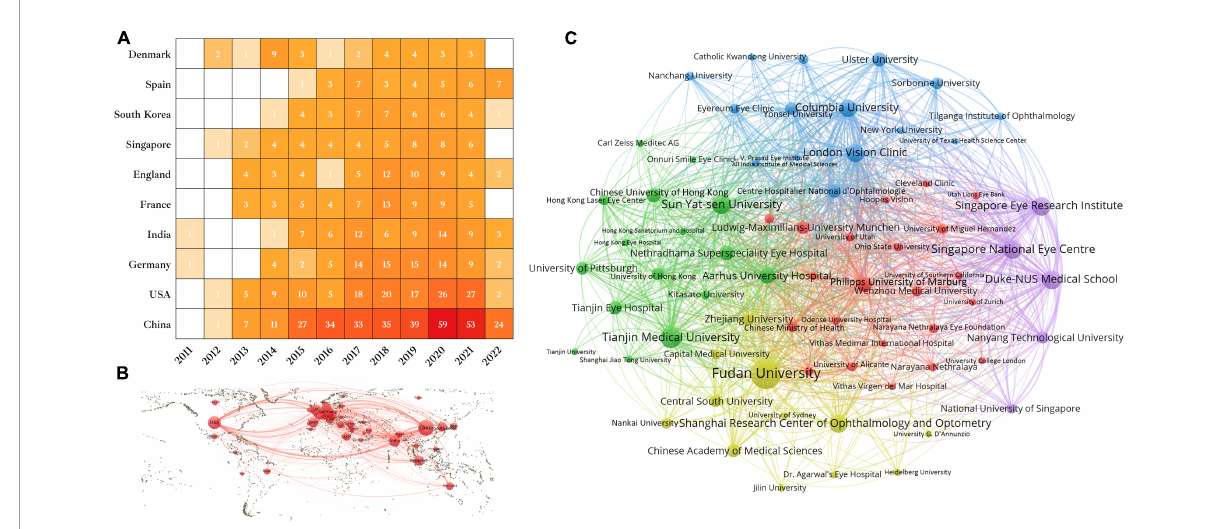
FIGURE3 The annual output of publications in the top 10 countries/regions (A) , the network map of countries/regions (B) , and institutions (C) related to SMILE research.